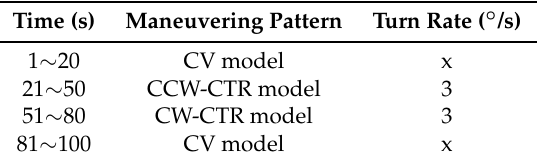
Table 2. Target maneuvering patterns over time. CV, constant velocity; CCW, counterclockwise; CW, clockwise; CTR, constant turn